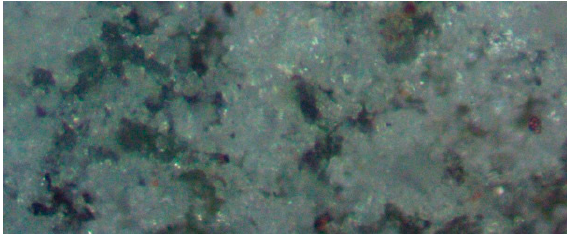
Figure 2. ST Trial Pellet (ST1a [16]) Following Desalination: Reflected Light; Halite on rough cut surface. Field of view = 0.378 mm; ZVI: water ratio = 18.31 g/L; Feed water salinity = 8.01 g/L; Product water salinity after 230 days = 2.52 g/L. NaCl removed = 5.49 g/L (0.30 g/g ZVI). Feed water pH = 6.27; Product water pH = 8.12.